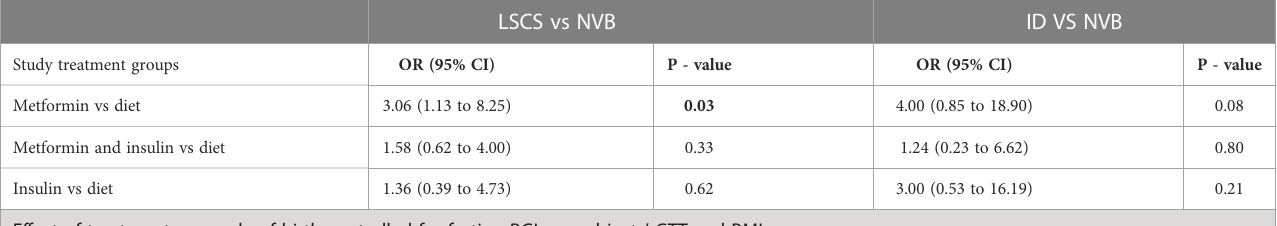
TABLE 3 Effect of GDM treatment procedure on mode of